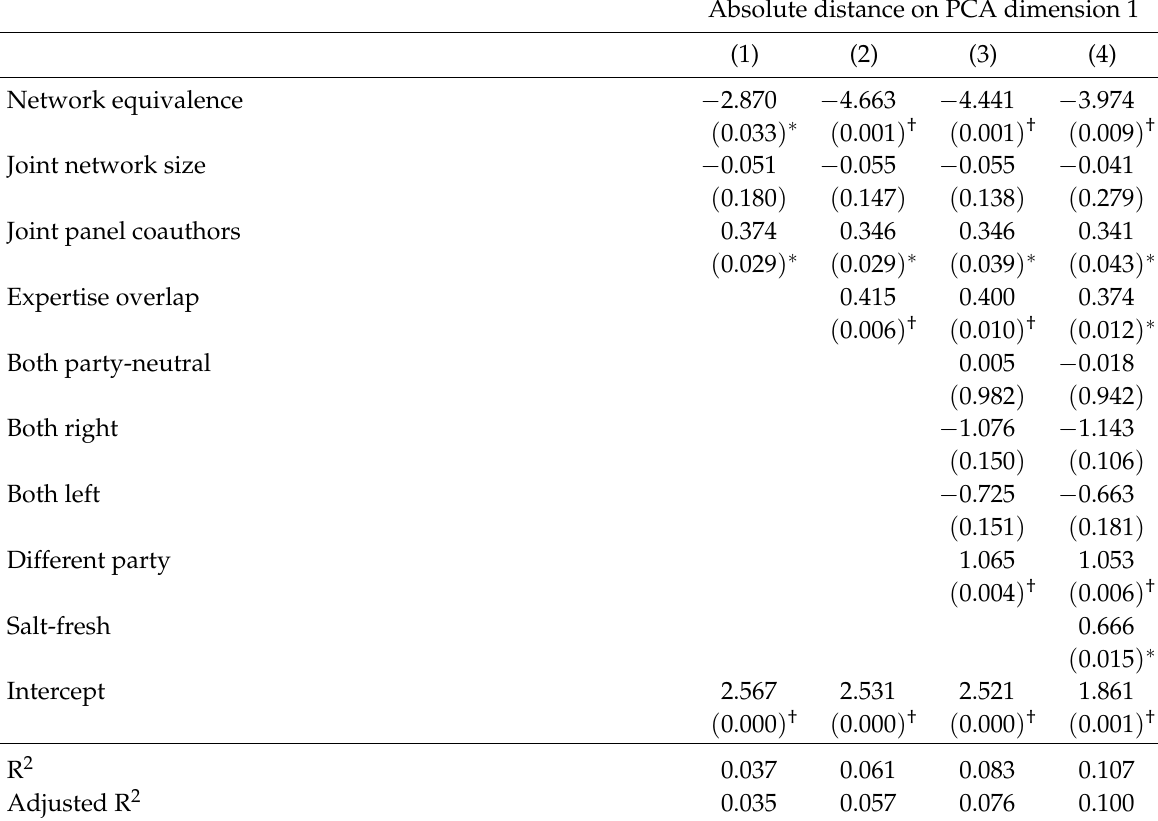
Table 3: Linear model of dyadic difference in latent